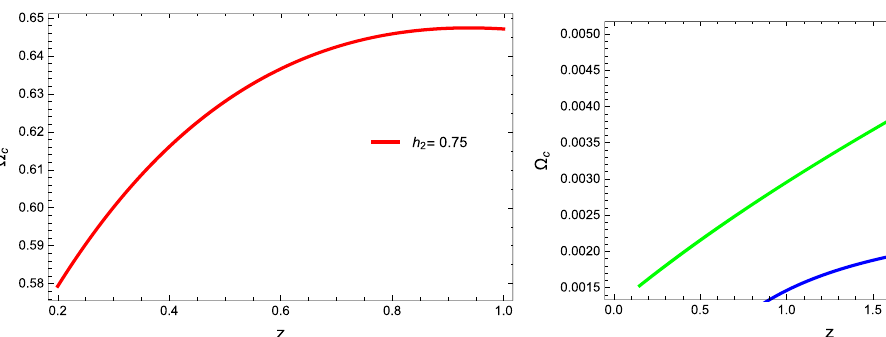
Fig. 14 Evolution of dark energy density parameter versus z